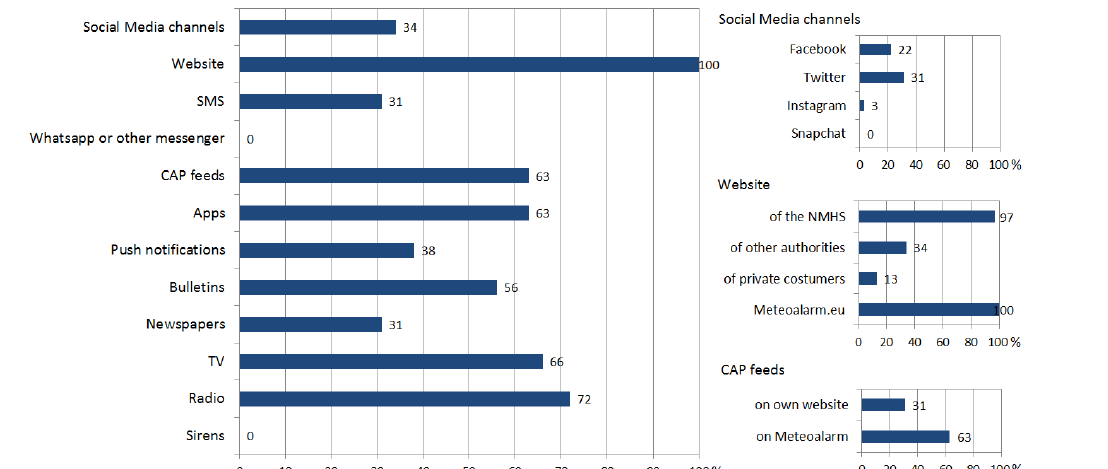
Figure 5. Dissemination channels regularly used for hydrometeorological warnings as surveyed at 32 of the 37 NMHSs participating in the EUMETNET Meteoalarm project. Further regular dissemination channels include email, ftp, YouTube and